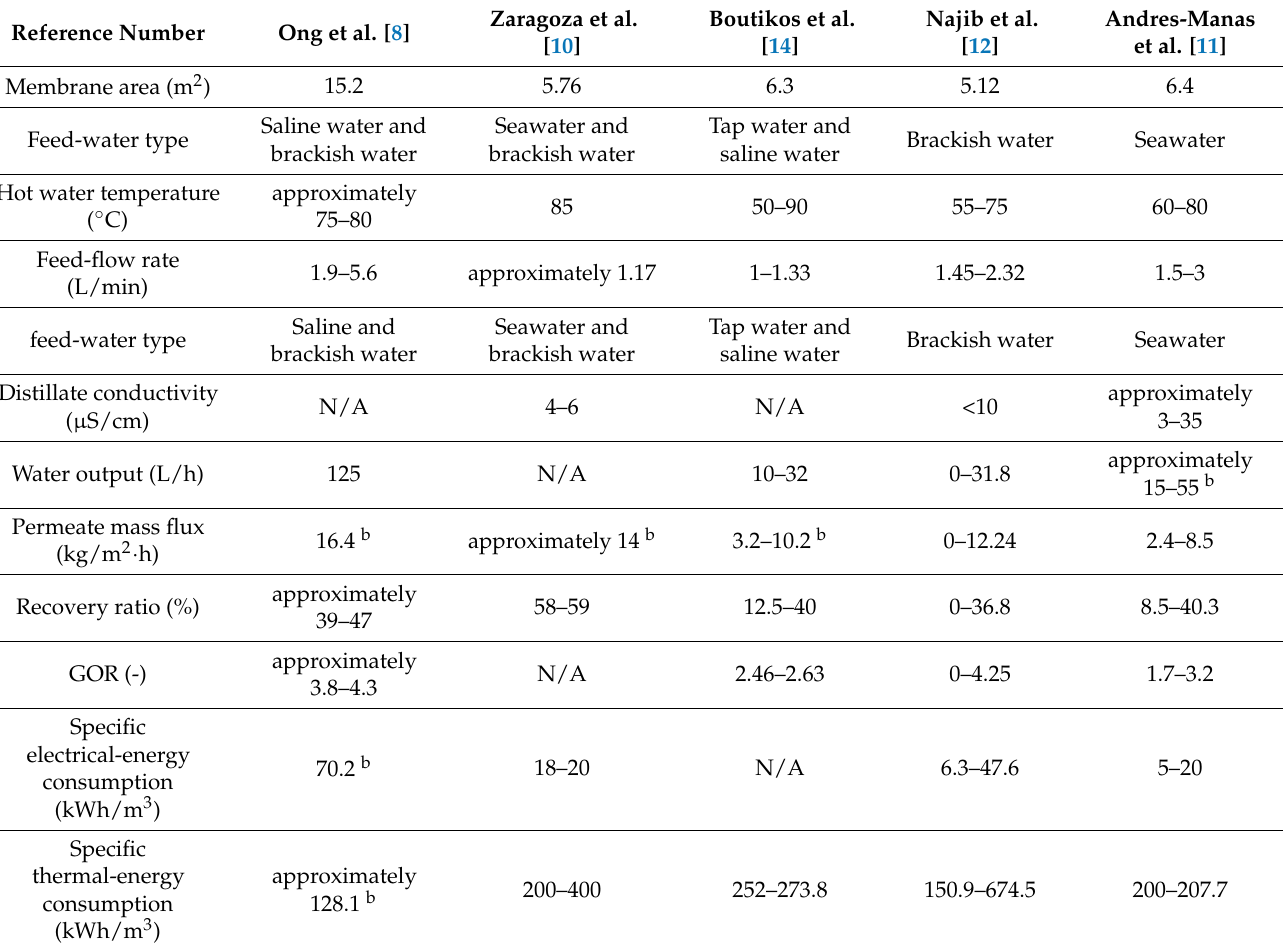
Table 1. Summary of results on V-MEMD units obtained from previous works